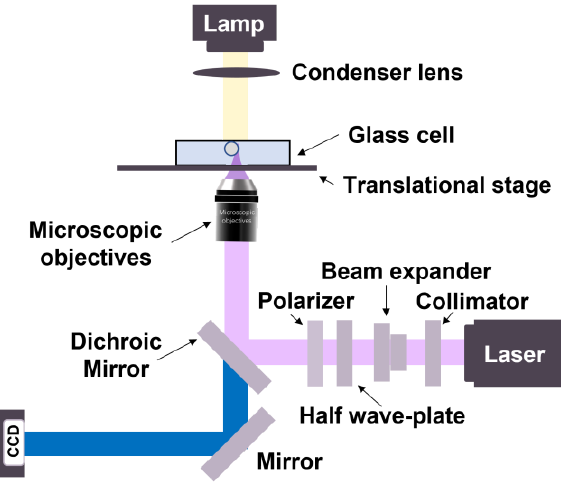
Figure 1. Schematics for the experimental setup.